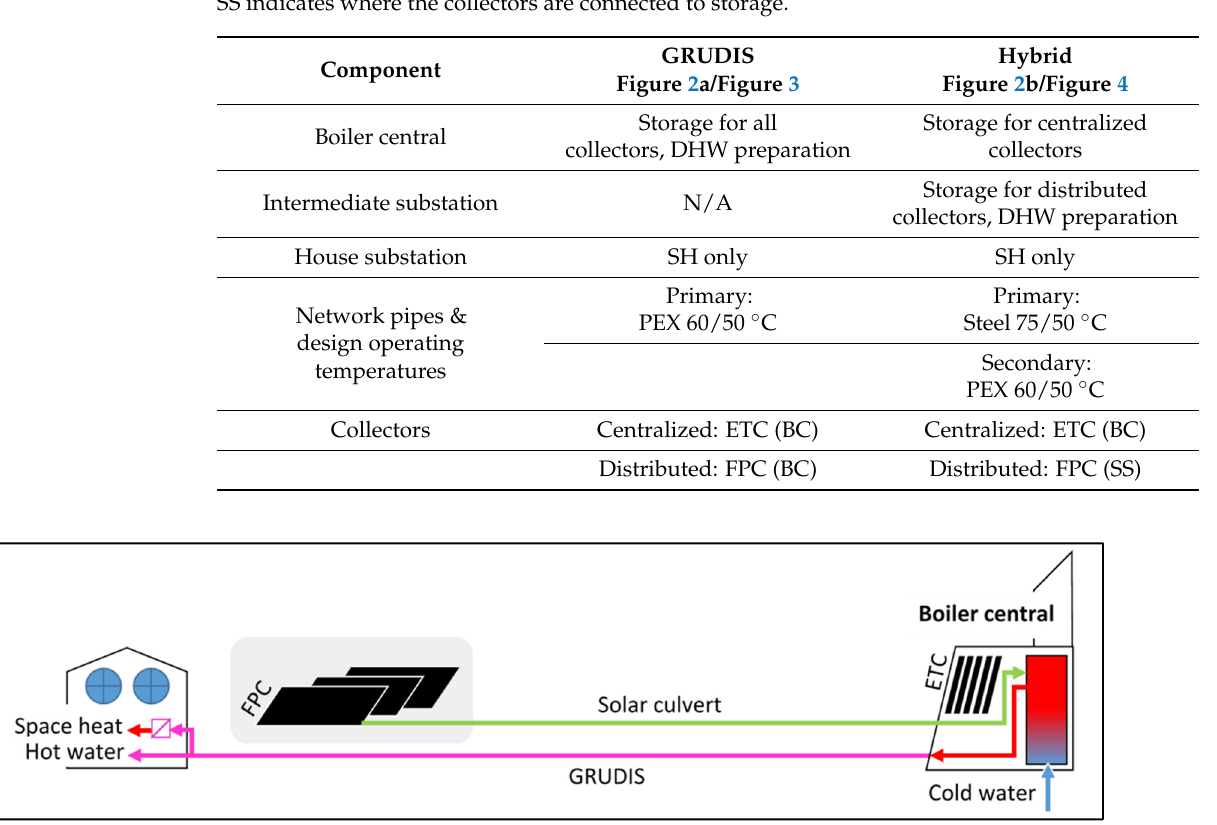
Figure 3. GRUDIS distribution—Simple schematic of GRUDIS distribution system with boiler central (BC) and single-family house. Ground-mounted flat-plate collectors (FPC) and evacuated tube collectors (ETC) on the BC [12].